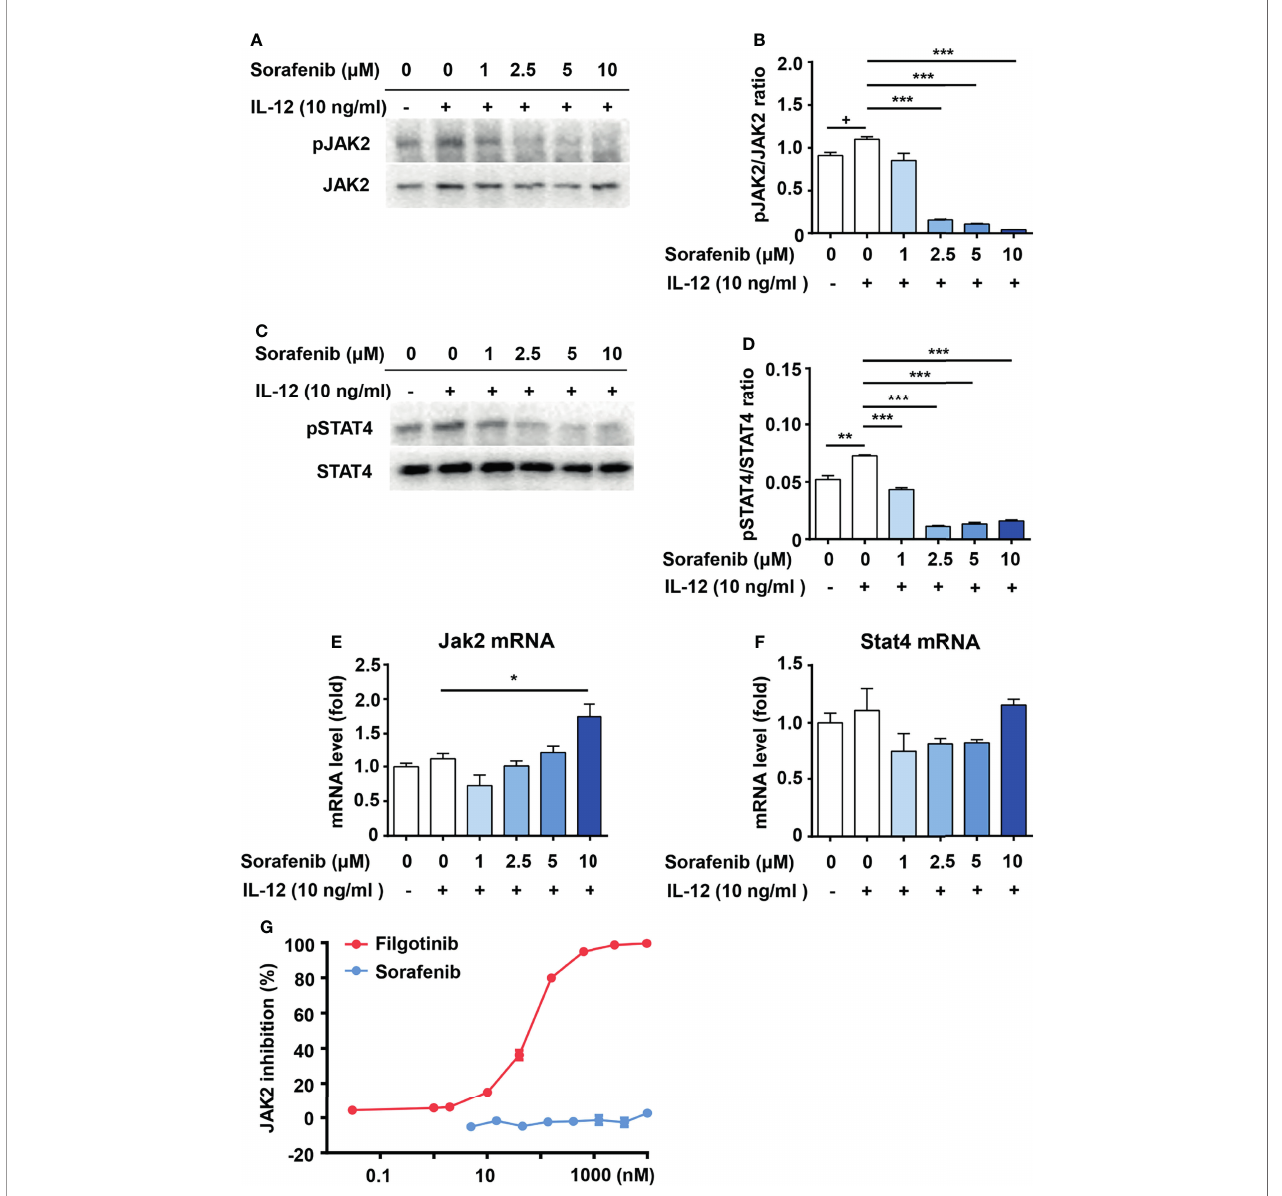
FIGURE 5 | Sorafenib indirectly inhibits phosphorylations of JAK2 and STAT4. Immunoblots and quantitation of pJAK2 (A, B) and pSTAT4 (C, D) in naive CD4 + T cells, which were stimulated with IL-12 in medium containing different concentration sorafenib as indicated. Quantitation of phosphorylated JAK2 and STAT4 normalized to total JAK2 and STAT4. RT-PCR analysis of JAK2 and STAT4 in naive CD4 + T cells, which were stimulated with IL-12 in medium containing different concentration sorafenib (E, F) as indicated. (G) The inhibition ratio of fi lgotinib and sorafenib on JAK2 activity. Data are representative of 3 independent experiments. Data represent means ± s.e.m. Statistical signi fi cance: + P < 0.1, * P < 0.05, ** P < 0.01 or *** P < 0.001. T-test used for statistical